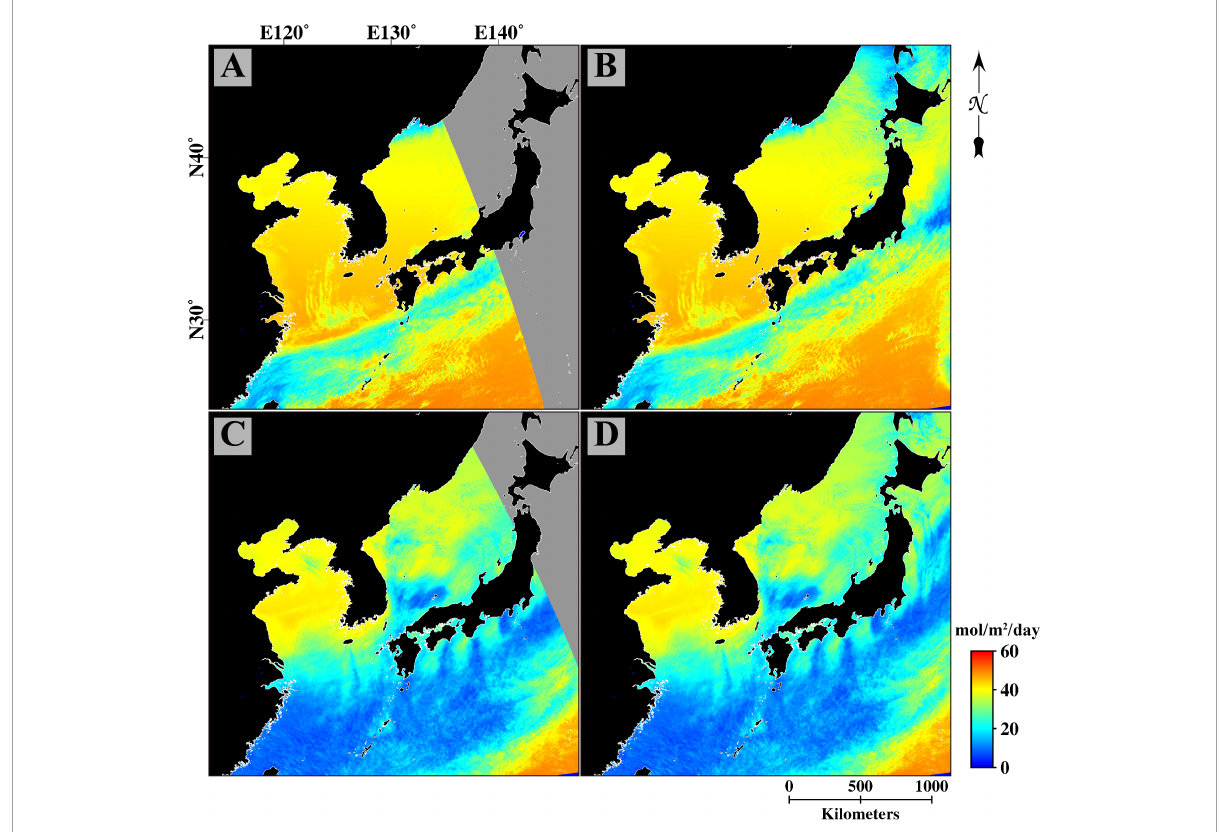
FIGURE 10 Missing data at large solar zenith angles (>75°). Daily PAR images (A) excluding and (B) including pixels with large solar zenith angles acquired on October 2, 2015. Daily PAR images (C) excluding and (D) including pixels with large solar zenith angles acquired on March 10, 2016. Gray areas in (A) and (C) were not calculated due to the large solar zenith